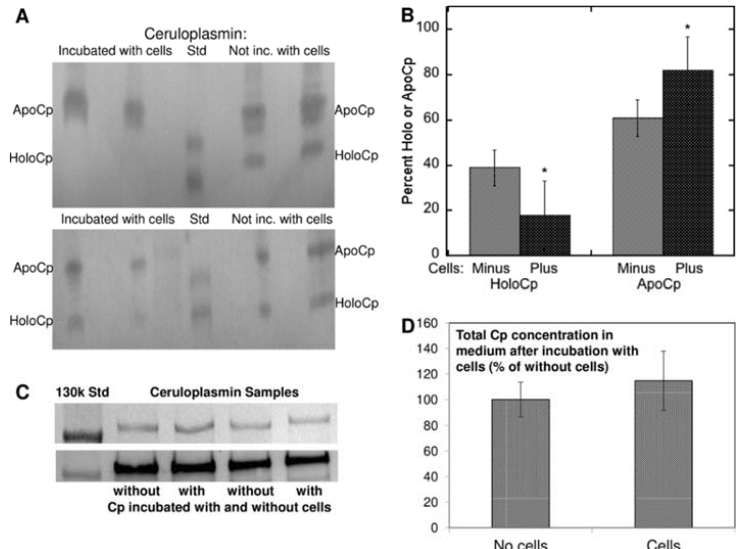
Figure 6. Ratios of apo to holo ceruloplasmin (Cp) in rat plasma, and effects of incubating purified rat ceruloplasmin with cultured cells. ( A ) Two examples of immunoblots of ceruloplasmin incubated without cultured cells (right two lanes), and with cultured cells (left two lanes), showing decreases or elimination of holoceruloplasmin by exposure to cells, and detecting the two forms by immunoblotting after native PAGE in 4.5% gels, with pH 8.8 resolving buffer. ( B ) Summarized densitometry data for multiple experiments of the type shown in ( A ), indicating loss of holo Cp and gain in apoCp during incubation with cells; * p < 0.01 for difference. ( C ) Evidence that total Cp levels did not change during incubation with cells. ( D ) Summarized densitometric data for experiments such as those in ( C ). Reprinted with permission from Ramos et al. [7].